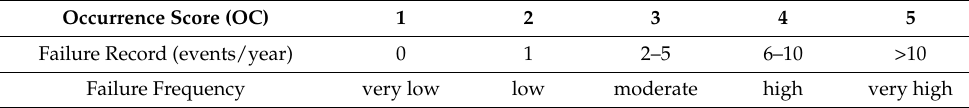
Table 2. Failure record and score for occurrence